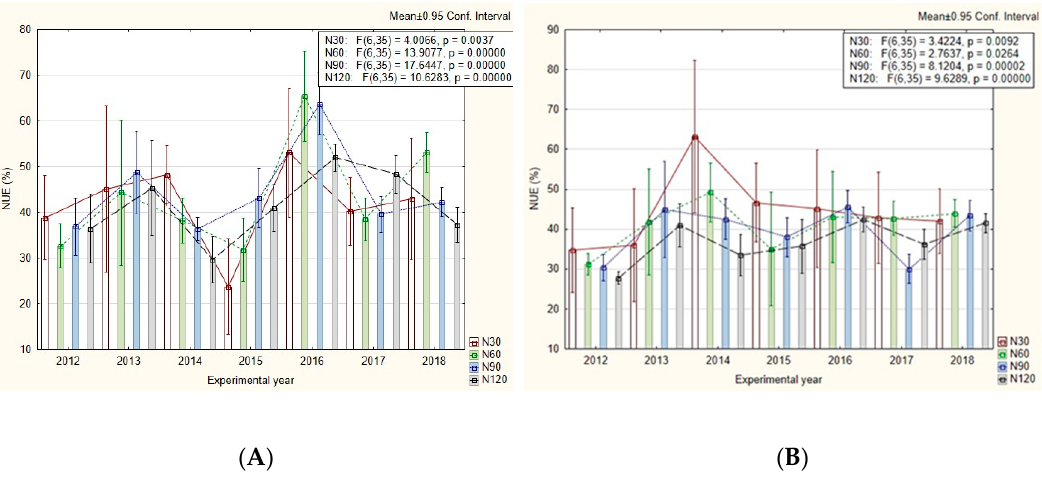
Figure 3. NUE as affected by planting pattern ( A )—wheat after maize (WM); ( B )—wheat after Figure 3. NUE as a ff ected by planting pattern ( A )—wheat after maize (WM); ( B )—wheat after soybean soybean (WS), N fertilization and experimental year. (WS), N fertilization and experimental